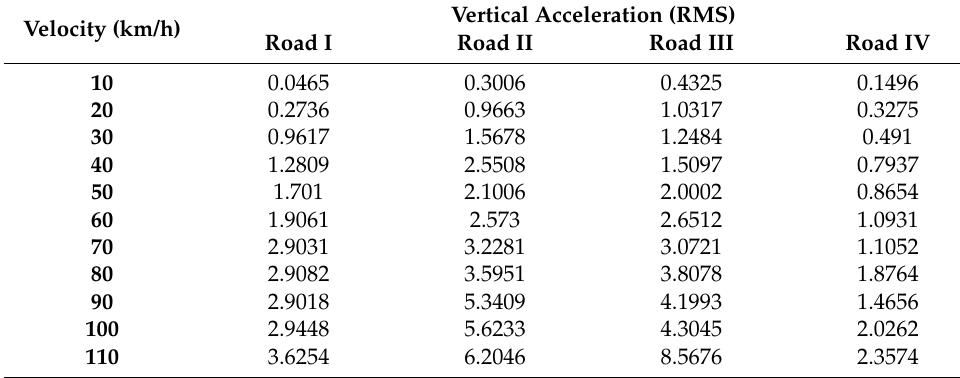
Table 2. Data stored in the